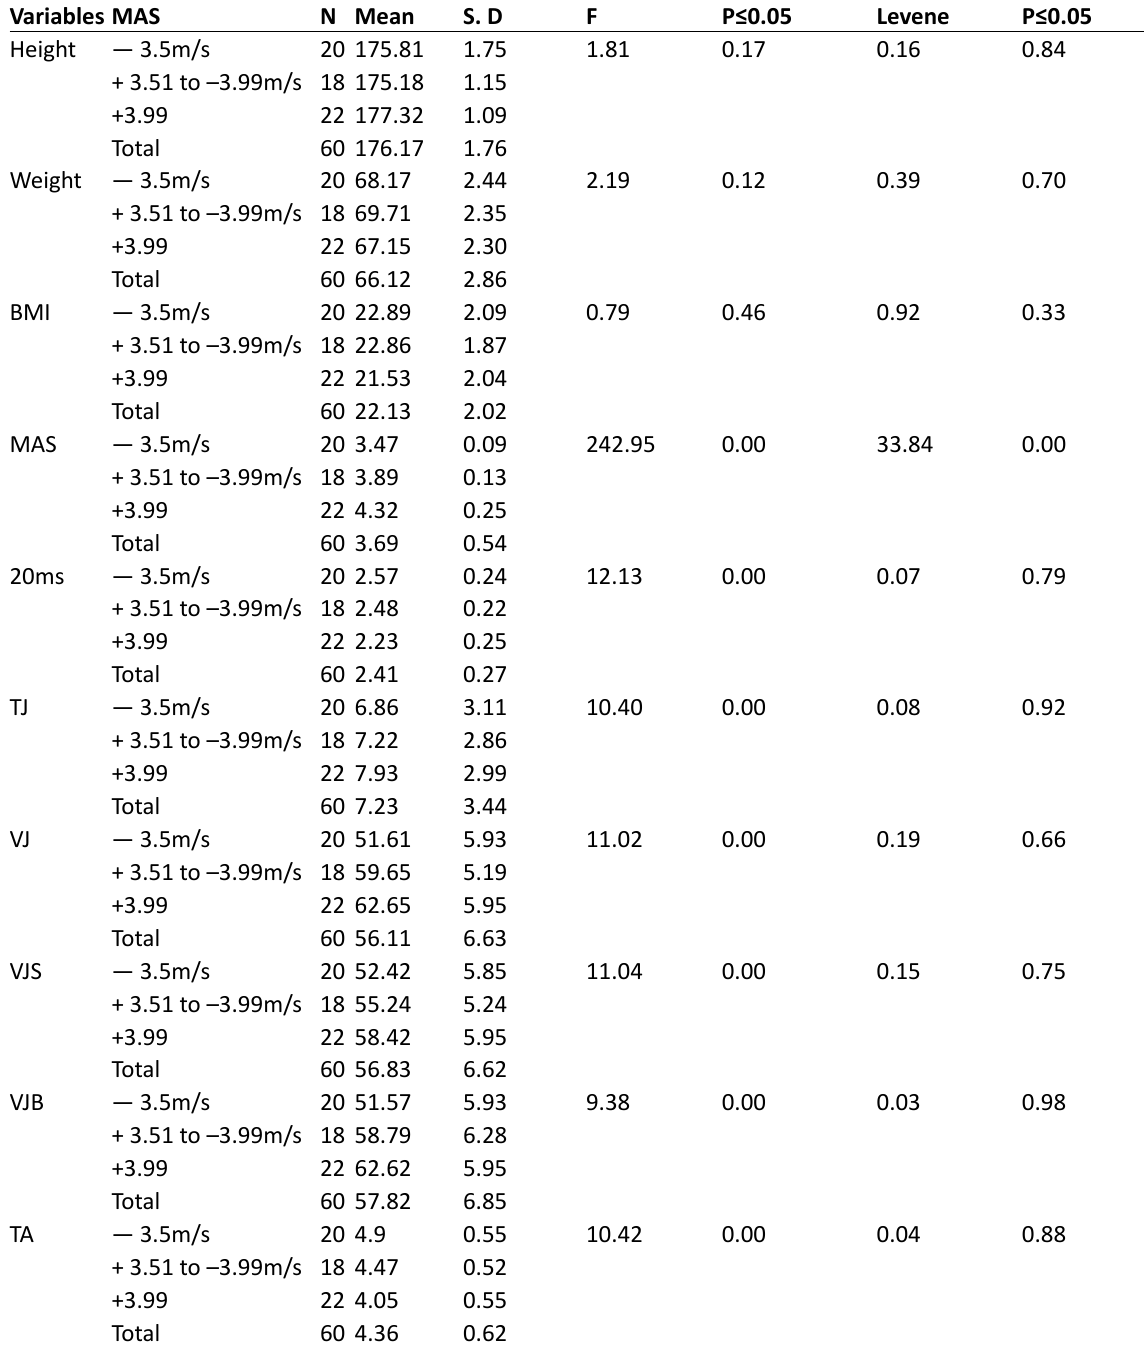
Table 1. Variability of indicators that characterizes motor abilities based on MSA levels Variables MAS N Mean S.